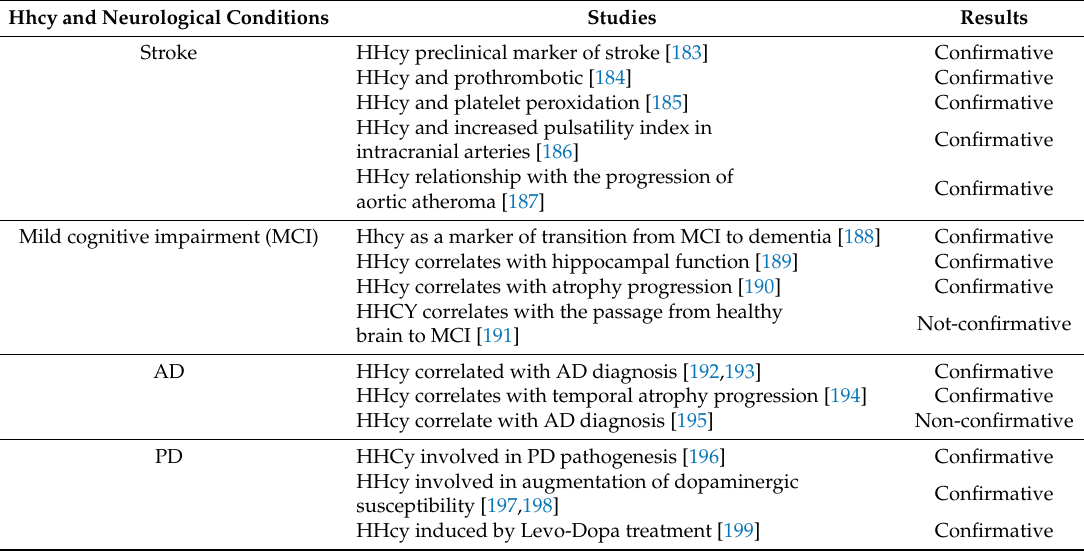
Table 1. Hhcy and main neurological